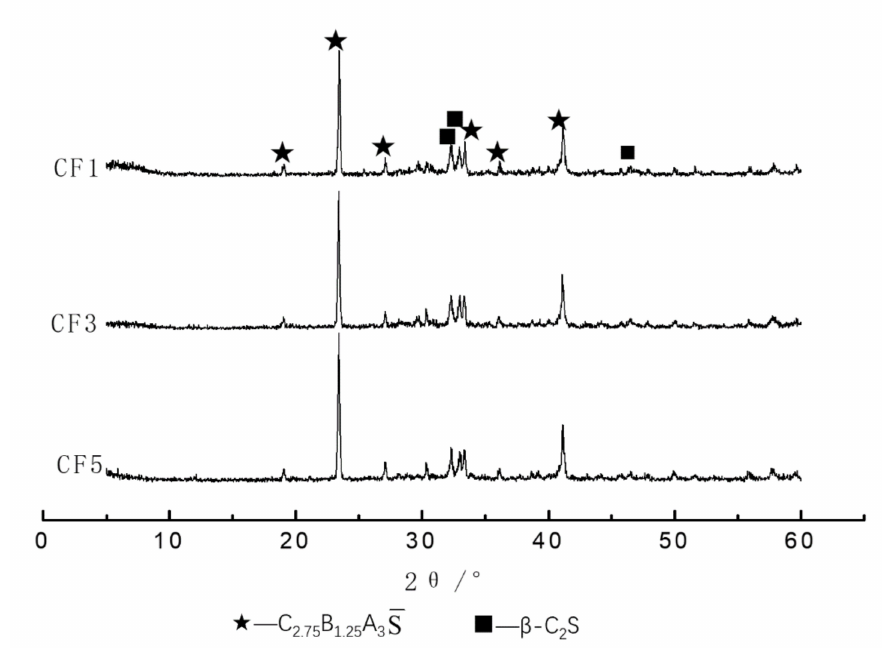
Figure 13. XRD patterns of different samples. Figure 14 is the SEM-EDS image of the CF3 clinker mineral at 1350 ◦ C. From Figure